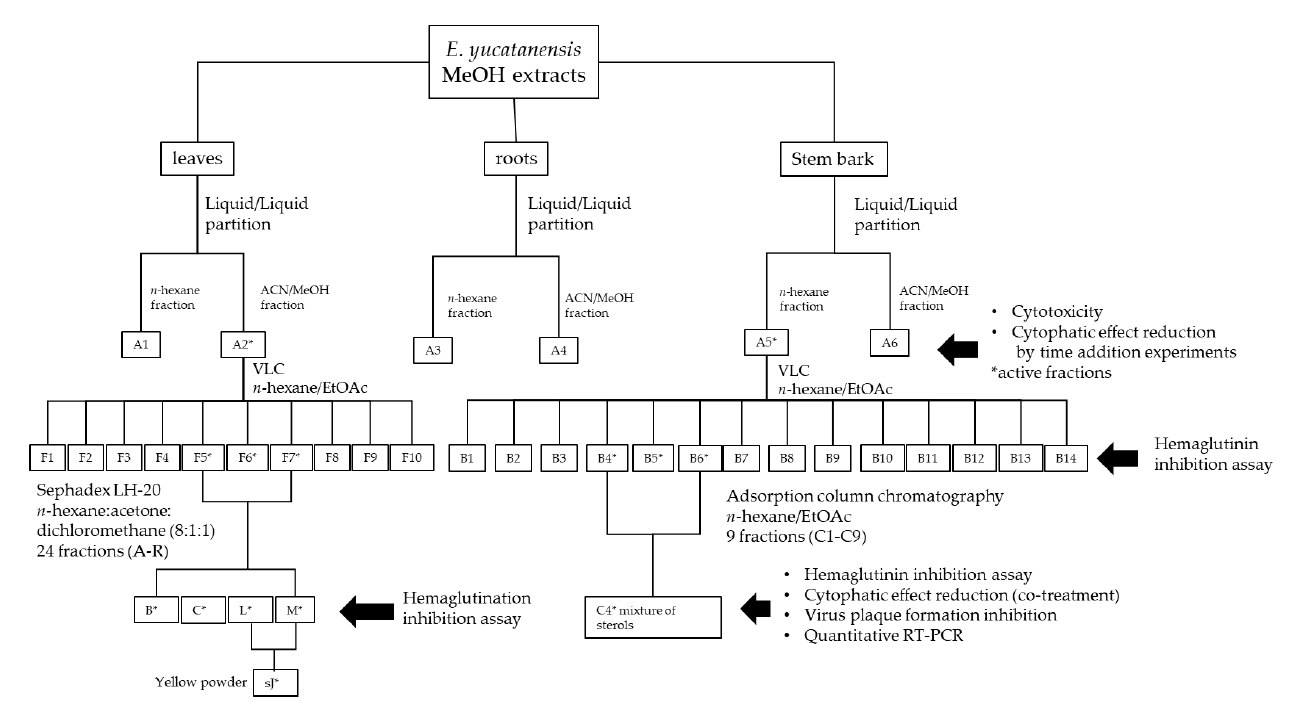
Figure 1. Experimental strategy for the bioassay-guided fractionation of antiviral compounds in Erythrostemon yucatanensis .